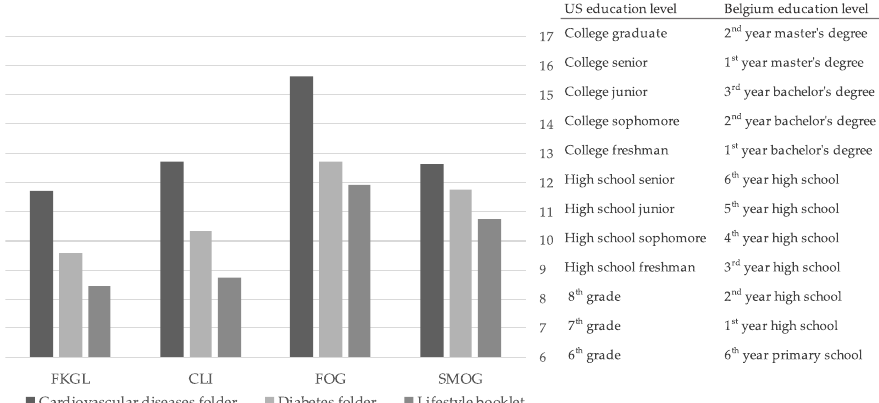
Figure 2. Readability evaluation of materials. Table 2. Overview of the participants’